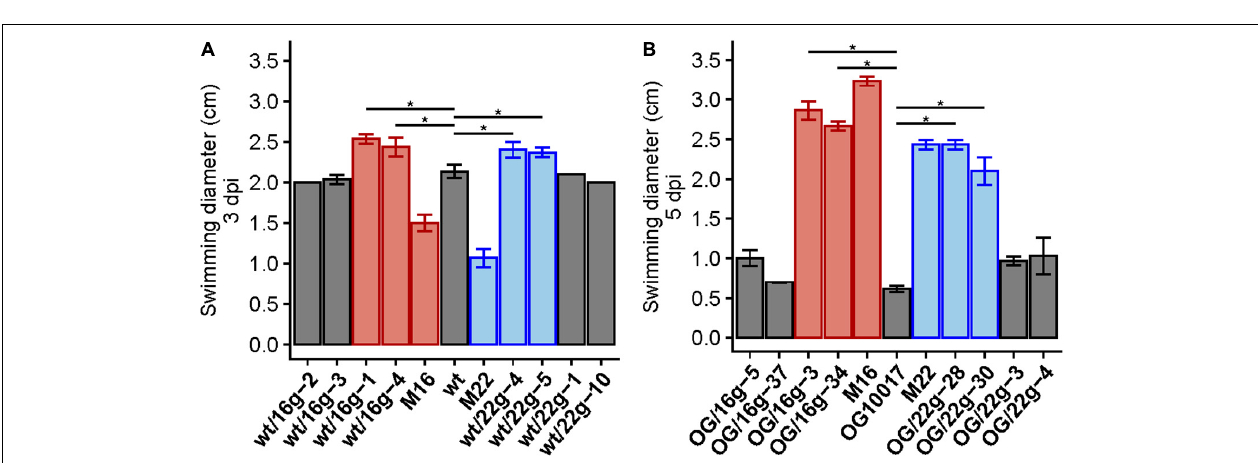
FIGURE 9 | Transduction of M16 and M22 versions of exoS increase swimming behavior in wild type and OG10017 backgrounds. Swimming diameters of wild type (wt), correlated suppressor mutants M16 and M22 and some gentamicin-resistant wild type transductants (wt/16g or wt/22g) 3 days post inoculation (3 dpi) (A) , as well as swimming behavior of OG10017 (OG), correlated suppressor mutants M16 and M22 and some gentamicin-resistant OG10017 transductants (OG/16g or OG/22g) 5 days post inoculation (5 dpi) (B) . Colors indicate the exoS version of strains: wt (gray), M16 (red), M22 (blue). The assays were performed at 28 ◦ C on LB/MC+-containing swim plates (0.3% agar). Values represent means of three independent experiments and standard deviation is shown. Pairwise comparisons were done using a Wilcox test and denoted by horizontal lines between the compared groups. Statistical significance is shown (* p < 0.05).